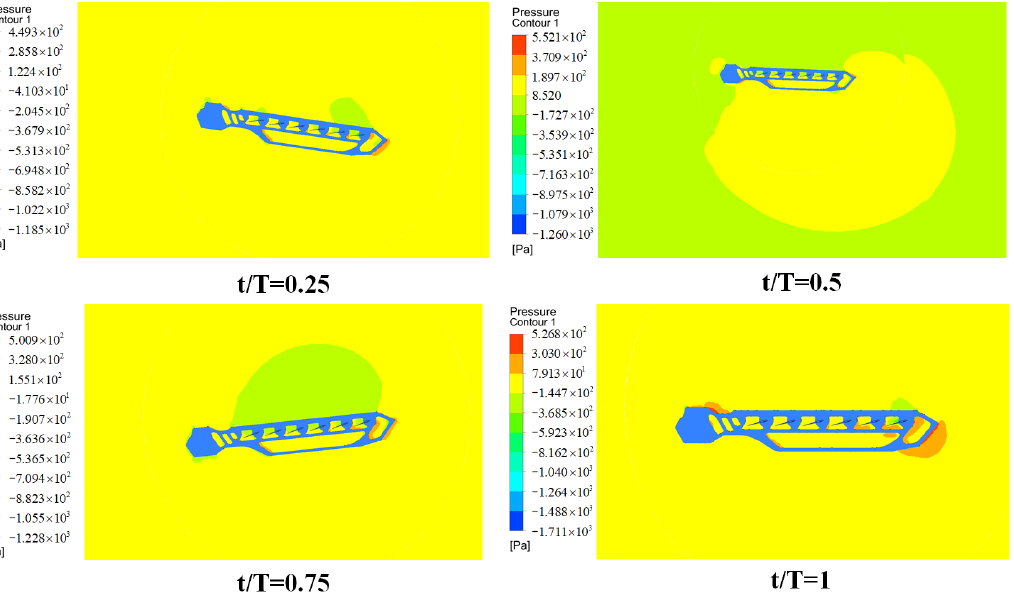
Figure 16. The pressure contours of the submerged glider in pure pitch simulation ( θ G =15